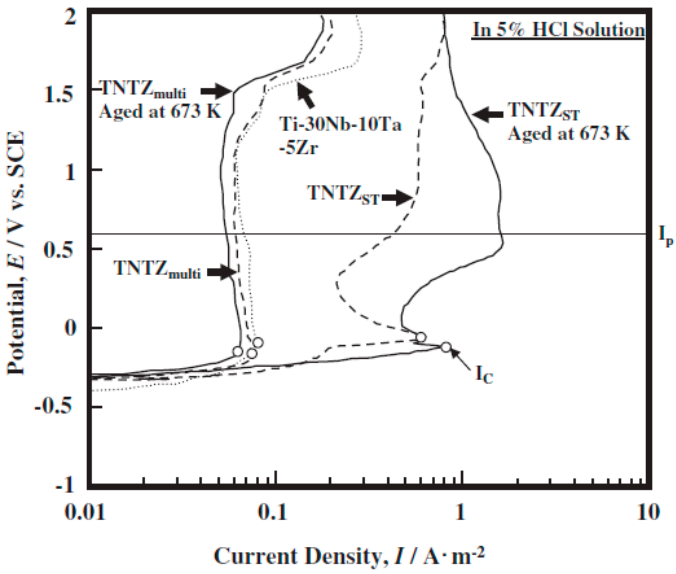
Figure 6. Anodic polarization curves of TNTZ ST (Ti-29Nb-13Ta-4.6Zr), TNTZ ST aged at 673 K for 259.2 ks TNTZ multi , TNTZ multi aged at 673 K for 259.2 ks and hot swaged Ti-30Nb-10Ta-5Zr in 5% HCl solution at 310 K [60].